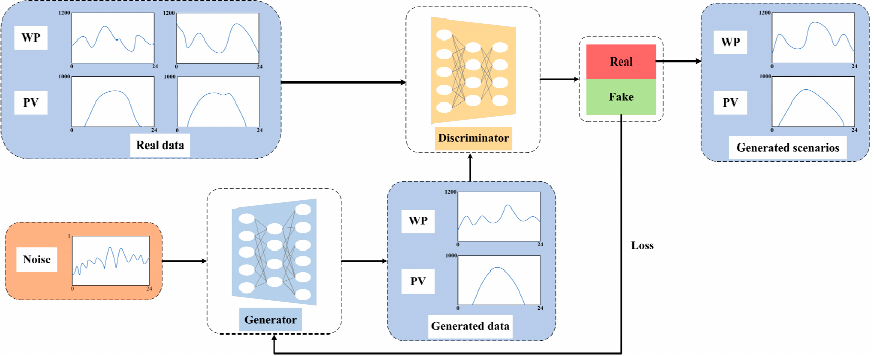
Figure 3. Structure of GAN.